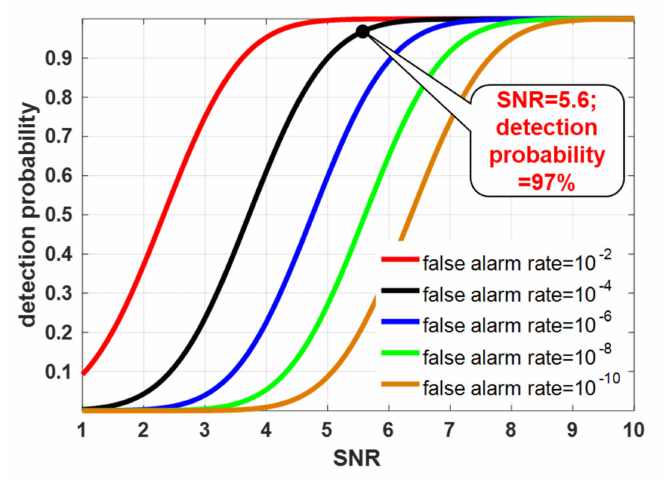
Figure 5. The relationship between signal-to-noise ratio and detection probability and the false alarm rate.